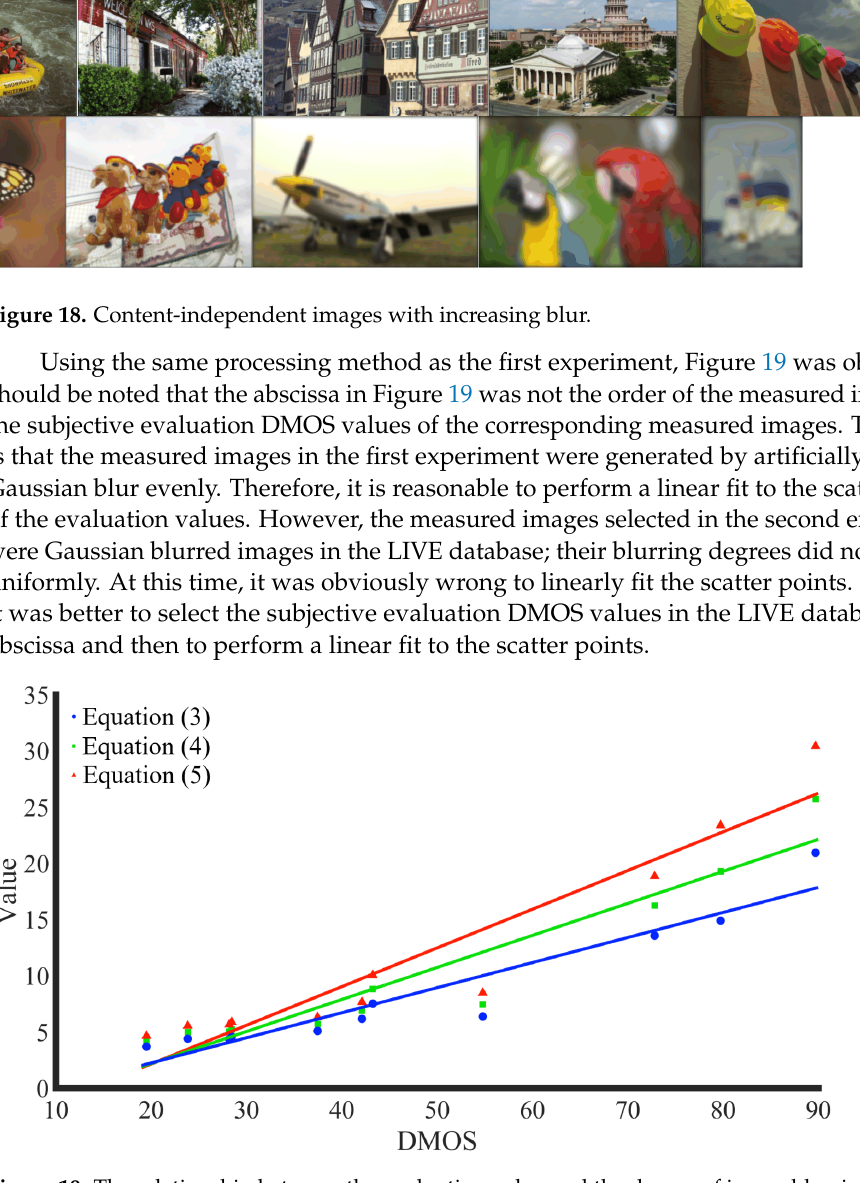
Figure 19. The relationship between the evaluation value and the degree of image blurring when the image contents are not the same.